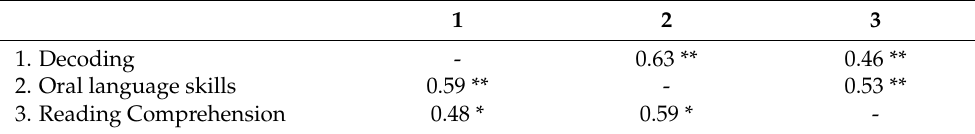
Table 4. Correlations between monolingual children’s performance on English decoding and oral language skills in Time 1 and reading comprehension in Time 2, with zero order correlations above the diagonal, and correlations between age-controlled variables below the diagonal.